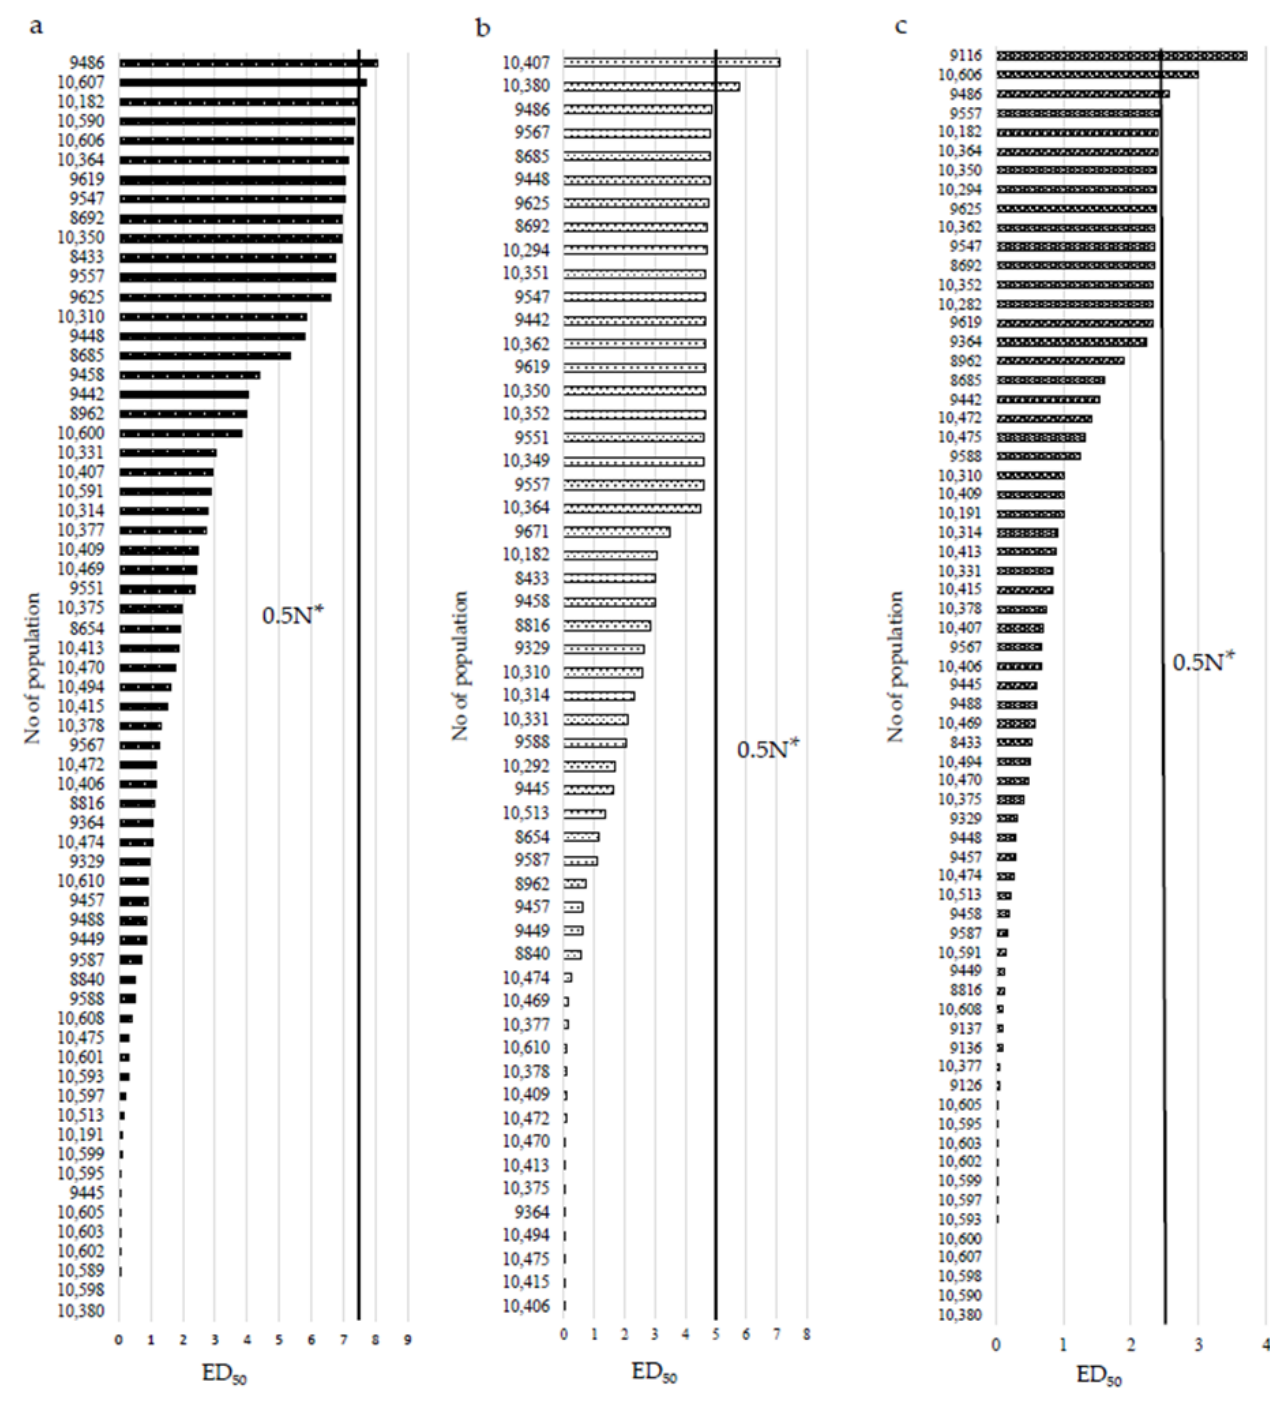
Figure 4. Populations of P. rhoeas susceptible to tribenuron-methyl ( a ), iodosulfuron-methyl-Na ( b ) and florasulam ( c ) characterised by ED 50 (effective dose causing 50% shoot fresh weight reduction in the treated plants). * Half of the recommended field dose of tribenuron-methyl, iodosulfuron- methyl-Na and